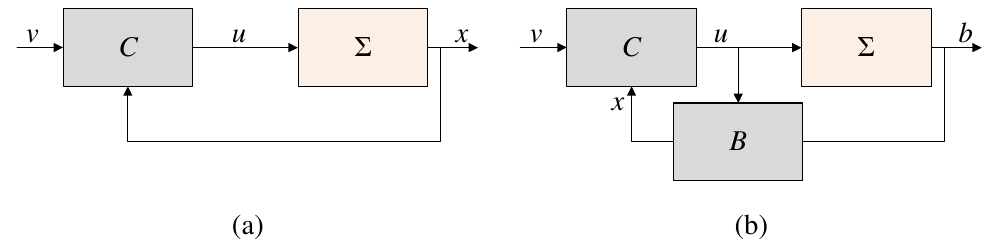
Figure 1. Basic configuration of corrective control systems: ( a ) Σ is an input/state ASM and ( b ) Σ is an input/output